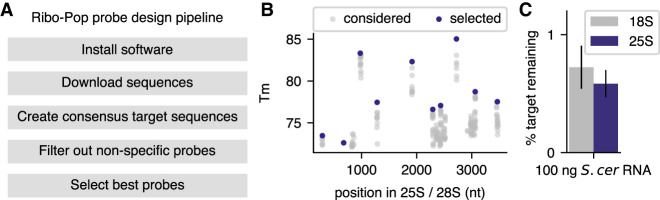
The Ribo-Pop probe design pipeline can be applied to other organisms. (A) The Ribo-Pop design pipeline. After software installation, the remaining steps can be automatically deployed. (B) An example output figure of the Ribo-Pop design pipeline after running the pipeline on the major rRNA transcripts of S. cerevisiae and S. pombe yeasts. The probe selection process for the large rRNA transcript is shown. Gray dots indicate possible probe placement sites based on conservation and sequence composition. Blue dots indicate the selected probes sites based on a desired probe set size of 10. (C) The Ribo-Pop probe set designed to target S. cerevisiae and S. pombe was applied to 100 ng of total RNA from S. cerevisiae. The averages of three experiments using different RNA samples are shown. Error bars are standard deviation.